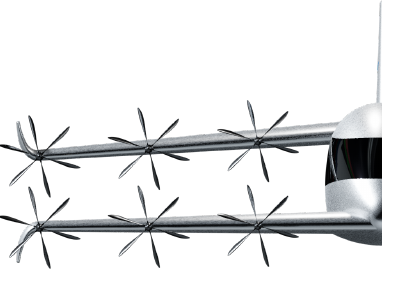
Figure 9. Front view of the aircraft showing the propeller